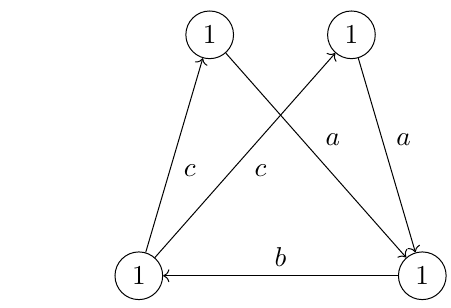
Figure 4 . Abelian quivers rising in the MPS formula for the 3-node quiver with rank (2 ; 1 ; 1). where the two options correspond to k = b + 2( c (cid:0) a ) even and odd. respectively. By comparing the result from the residue formula with (5.47), we can read o(cid:11) the